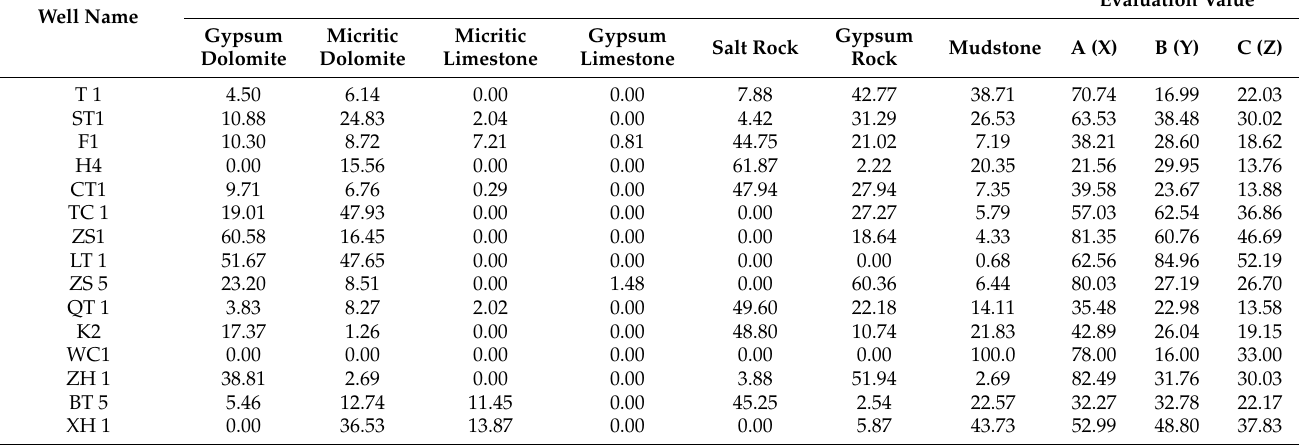
Table 4. Evaluation value of each mechanical